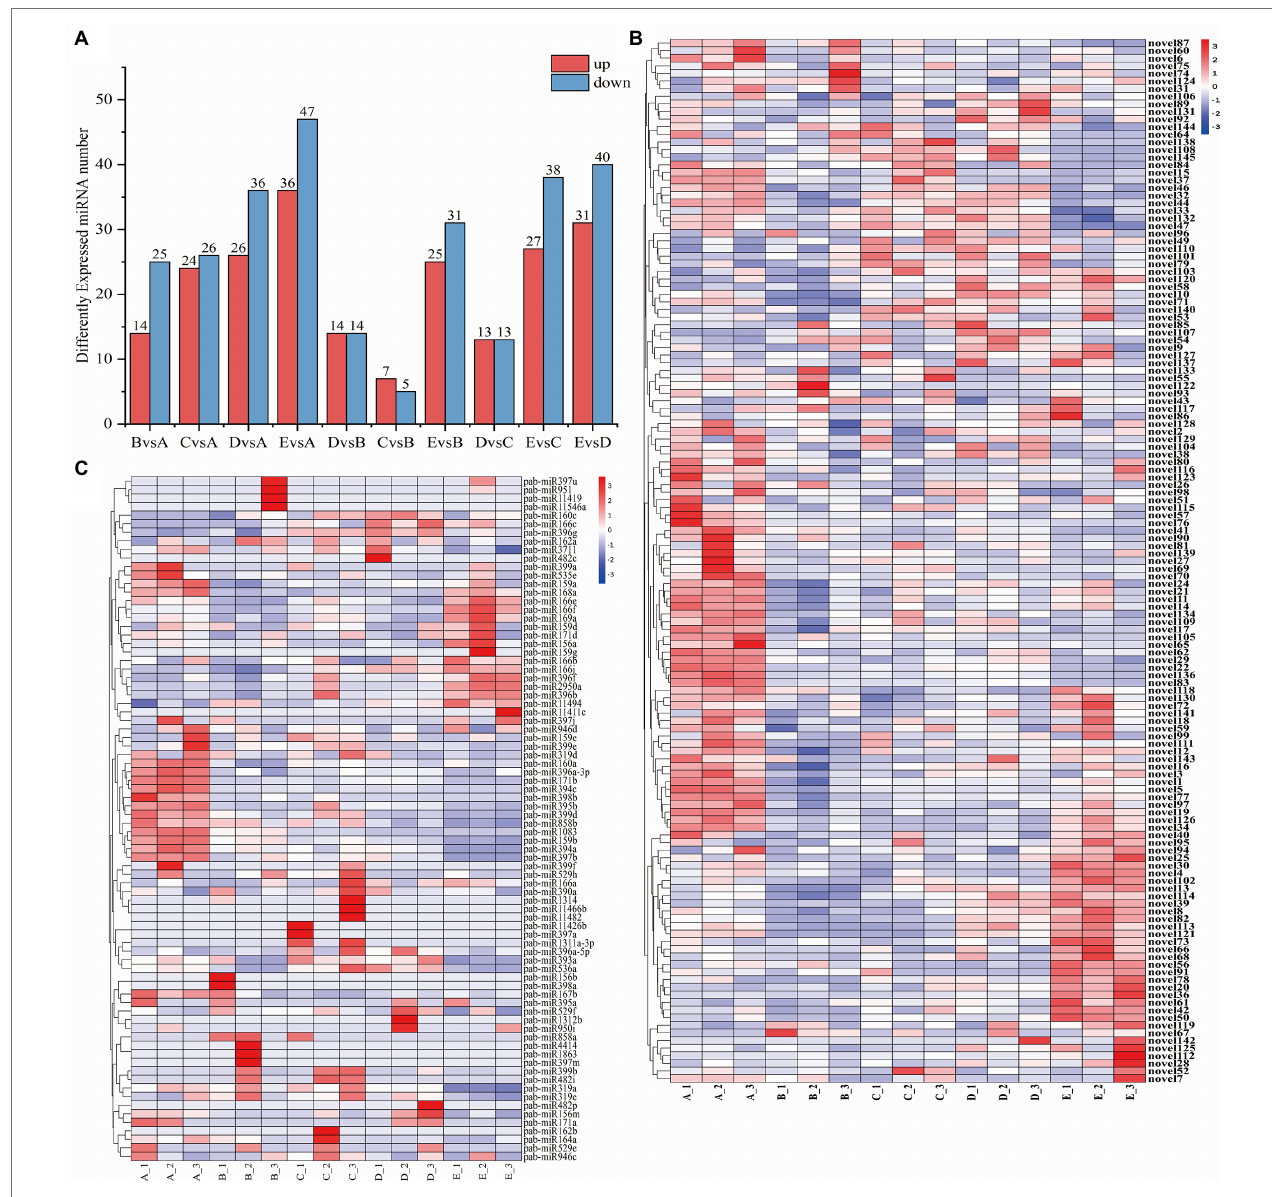
FIGURE 5 | (A) Number of differentially expressed miRNAs when cross-comparing cambium developmental stages. The x-axis indicates which stages are being compared to each other, and the y-axis indicates the number of differentially expressed miRNAs within each comparison. (B) Clustering heatmap of differentially expressed novel miRNAs. The x-axis presents the sampled stages (A, B, C, D, and E; see “Materials and Methods”) and the biological replicate number. The miRNAs are shown on the y-axis. (C) Clustering heatmap of differentially expressed known